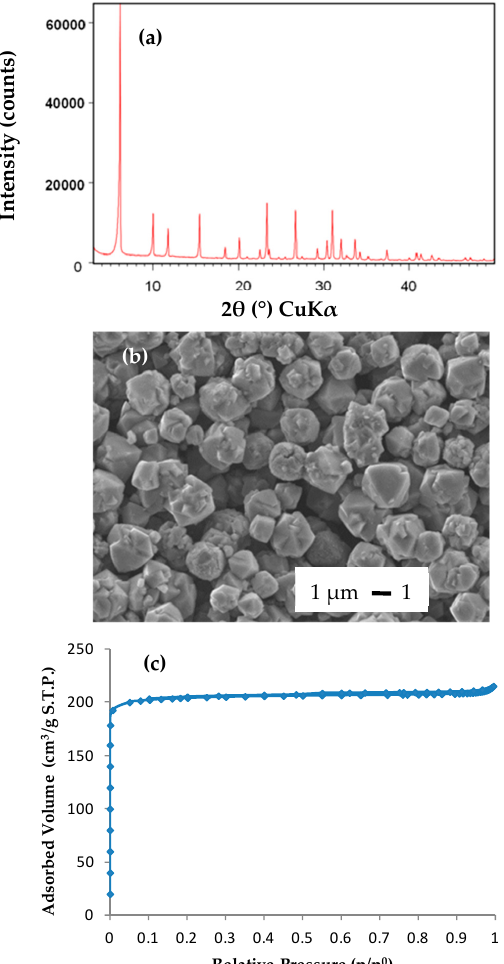
Figure 1. Pure 13X zeolite powder (FAU): ( a ) X-ray diffraction (XRD) pattern; ( b ) scanning electron micrograph; ( c ) nitrogen adsorption-desorption isotherms at − 196 °C .